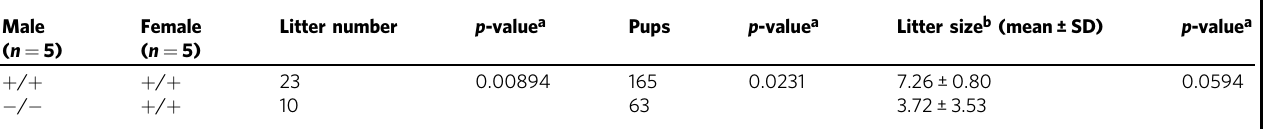
Table 1 Statistical analysis of fertility in Lcrmp-1 + / + and Lcrmp-1 − / −